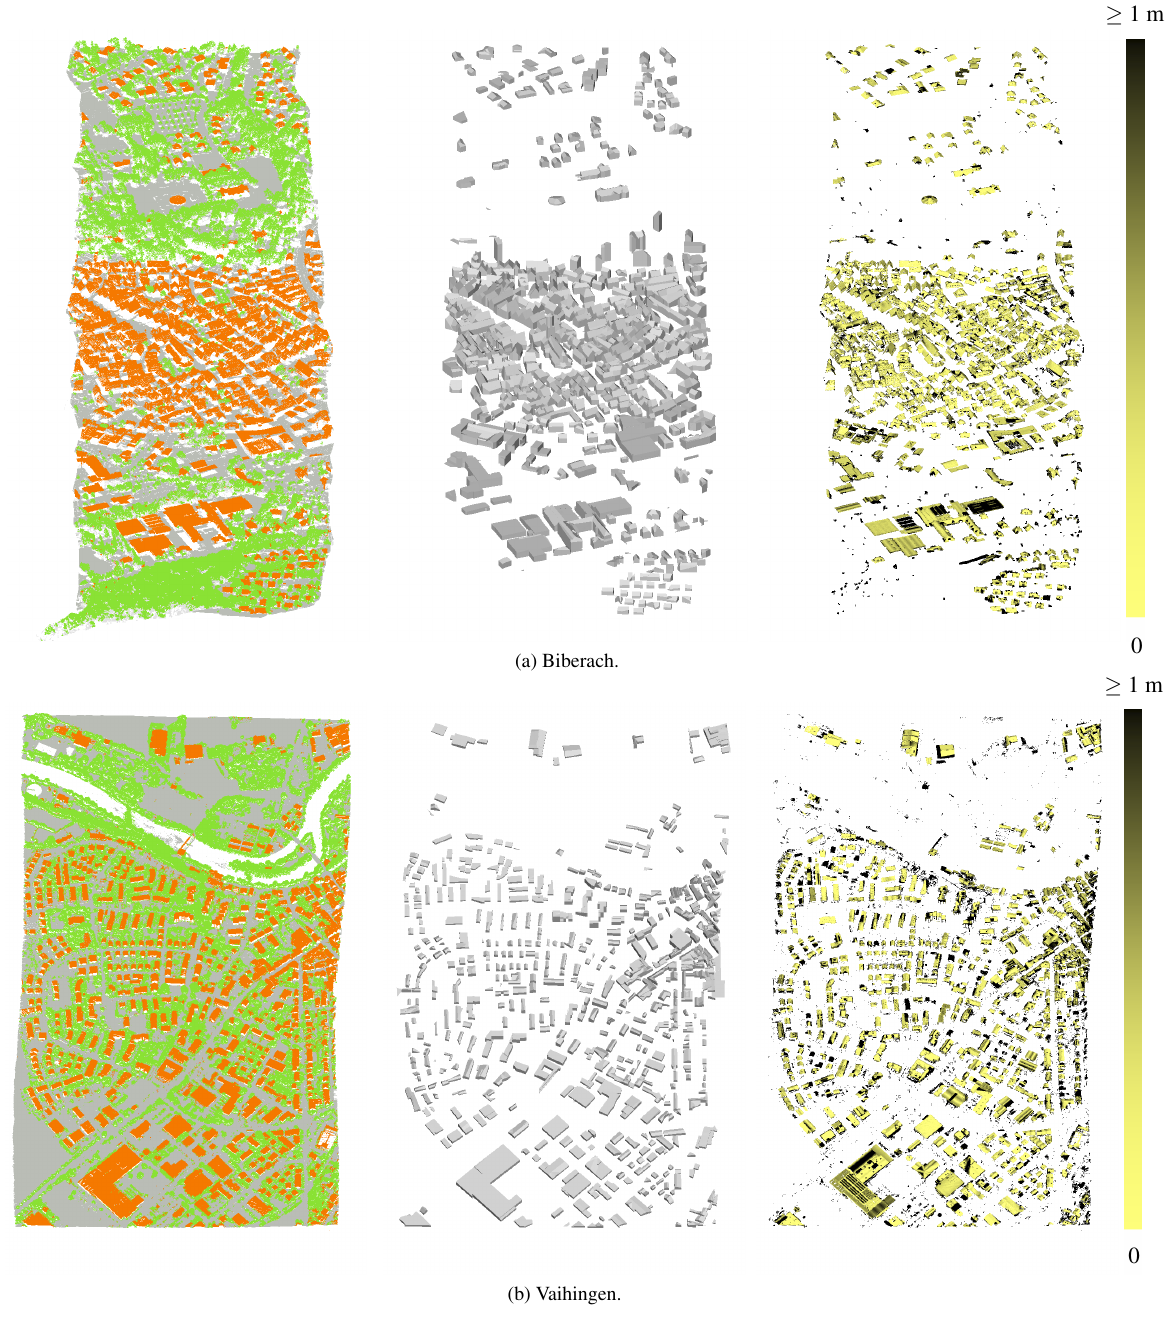
Figure 2. Results on European-style urban landscapes. Left column : classified point clouds. Points labelled as ground, vegetation or buildings are colored in gray, green and red, respectively. Center column : reconstructed models. Right column : altimetric error map, in which a darker color represents a larger error. From left to right : classified point